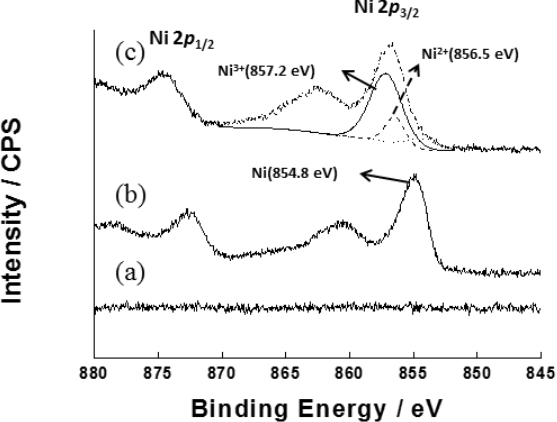
Figure 3. XPS spectra of Ni 2p of ( a ) bare ITO electrode; ( b ) heated DSPNCE at 400 °C for 30 min; and ( c ) electrodeposited Ni(OH) 2 /NiOOH on the DSPNCE after scanning 30 cycles in 0.1 M NaOH.